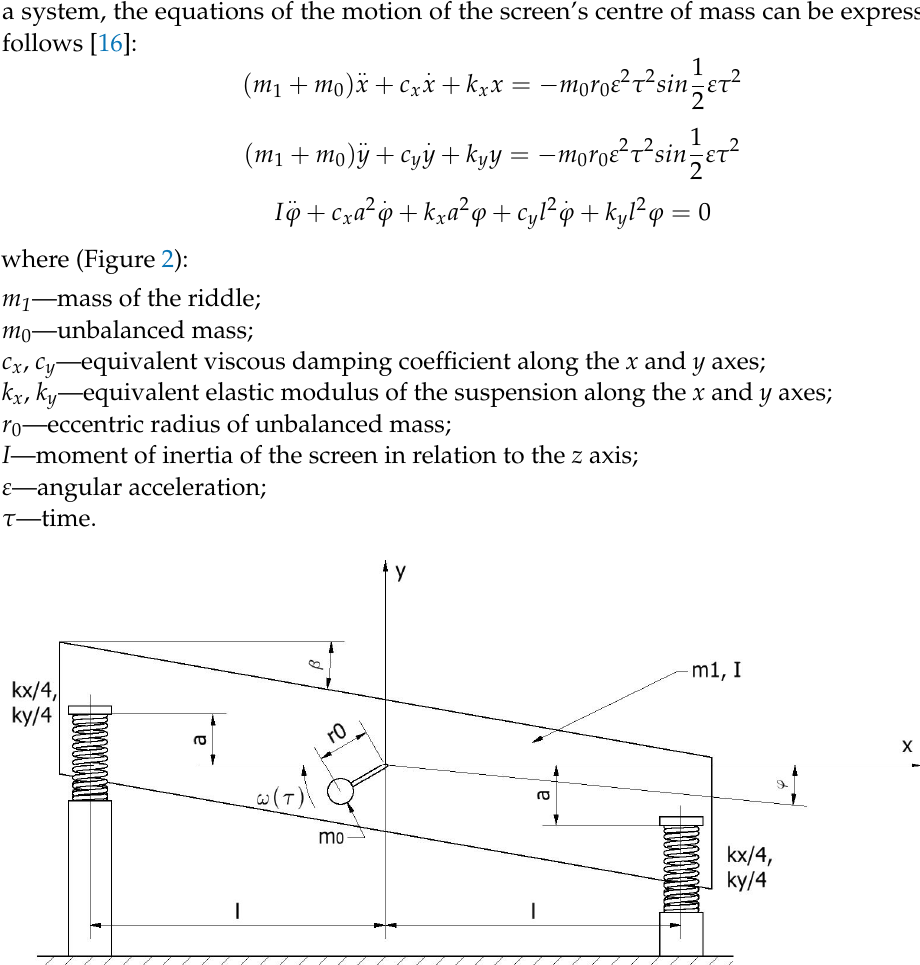
Figure 1. Physical model of the vibrating screen with circular vibrations used in the analysis: 1— vibrating mass; 2—inertial vibrator; 3—elastic elements supporting the screen; 4—supporting structure; 5—screen surface.